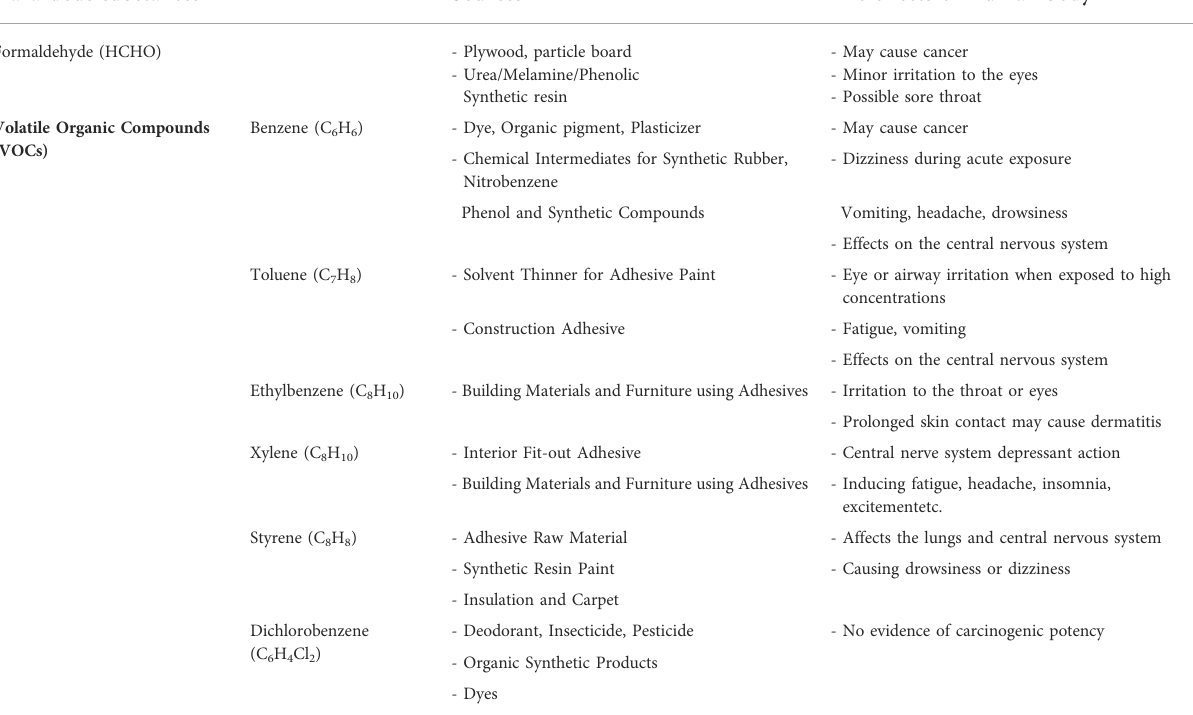
TABLE 1 The effects of hazardous substances on the